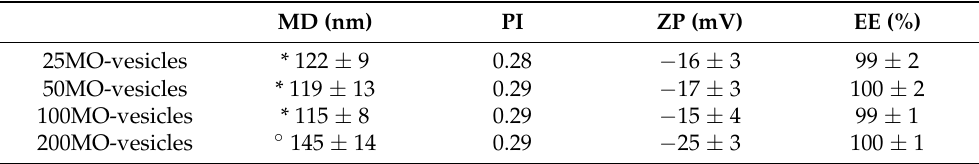
Table 2. Mean diameter (MD), polydispersity index (PI), zeta potential (ZP) and entrapment efficiency (EE) of quercetin and mint oil loaded vesicles. Each value represents the average ± standard deviation of at least six replicates.